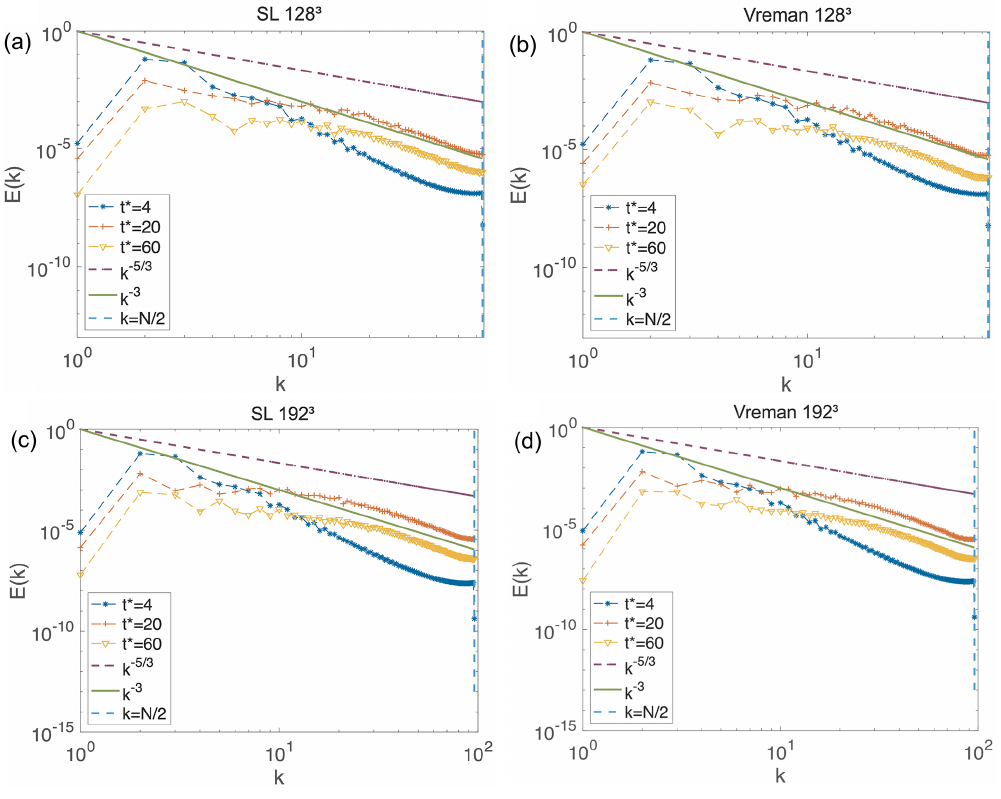
Figure 10. Kinetic energy spectra obtained using (a) 128 3 points and SL, (b) 128 3 points and Vreman, (c) 192 3 points and SL, and (d) 192 3 points and Vreman.